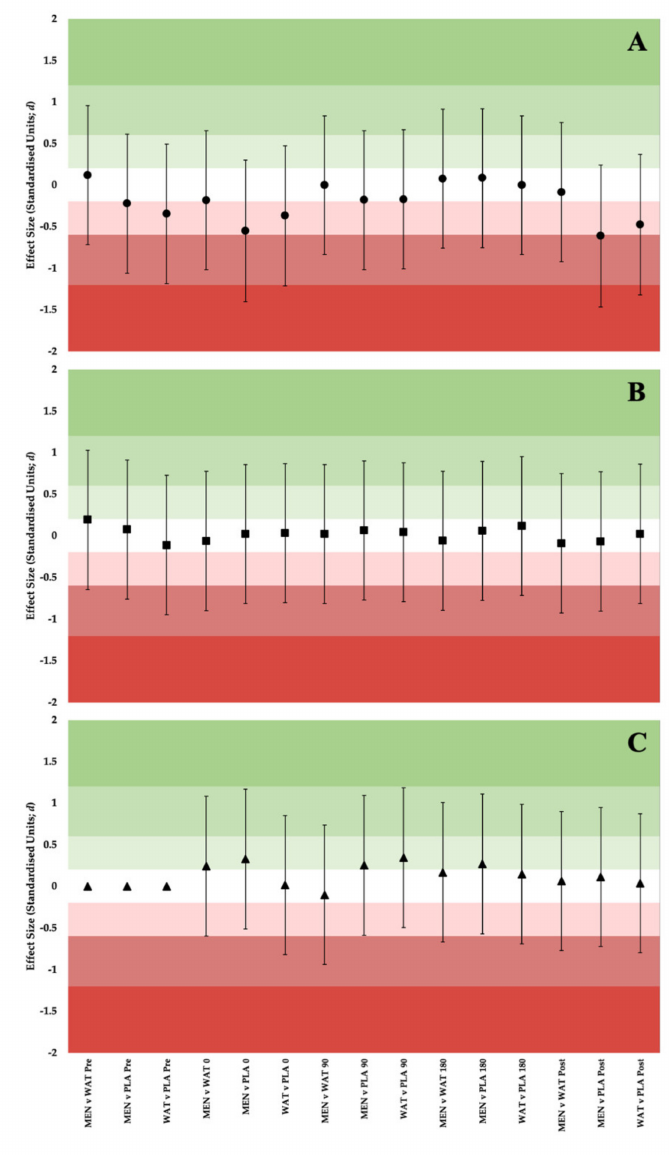
Figure 6. Forest Plot of ES ± 90% CI at matched time points and between solutions for ( A ) Thermal Comfort, ( B ) Thermal Sensation and ( C ) Rating of perceived